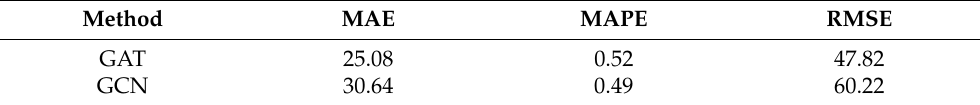
Table 5. MAE, MAPE and RMSE of GAT and GCN in Shanghai metro passenger flow dataset. Method